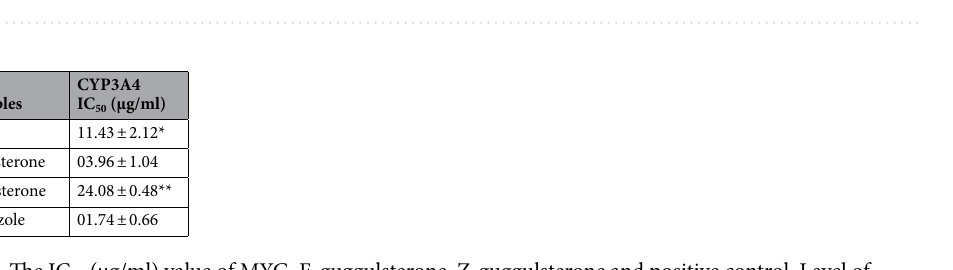
Table 1. The IC 50 (µg/ml) value of MYG, E-guggulsterone, Z-guggulsterone and positive control. Level of significance at * P < 0.05, ** P < 0.01.